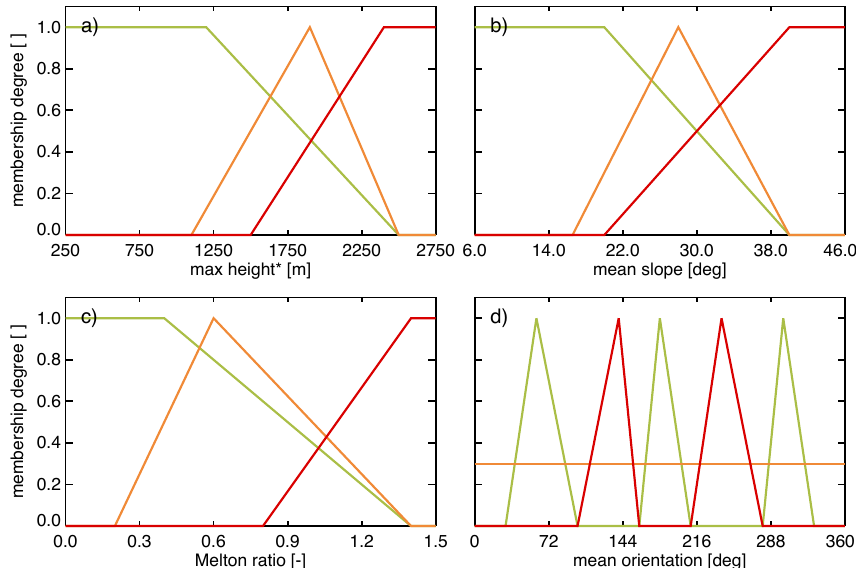
Figure 5. Membership functions used to assess the susceptibility of the subbasins based on (a) (cid:49)h max , (b) mean slope, (c) Melton ratio and (d) mean orientation of the subbasin. The green, orange and red lines correspond, respectively, to the membership functions for the susceptibility classes “low”, “moderate” and “high”.